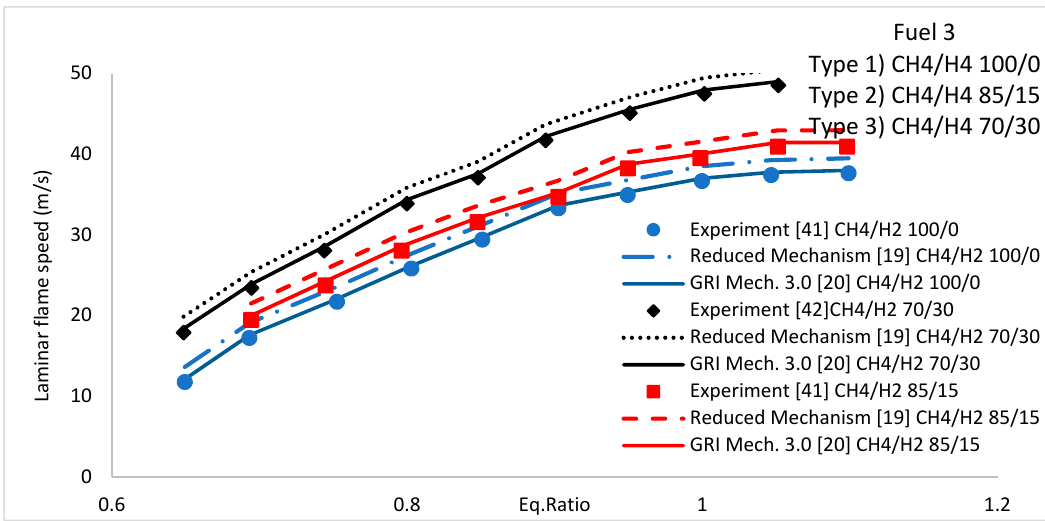
Figure 5. Comparison of the calculated laminar flame speed using the reduced mechanism [19] and GRI Mech. 3.0 [20] and the experimental measurements from References [41,42] for Fuel 3 (CH 4 /H 2 100/0%, 70/30% and 85/15%) at pressure 1 bar, eq.ratio 0.65–1.1 and temperature 300 K.